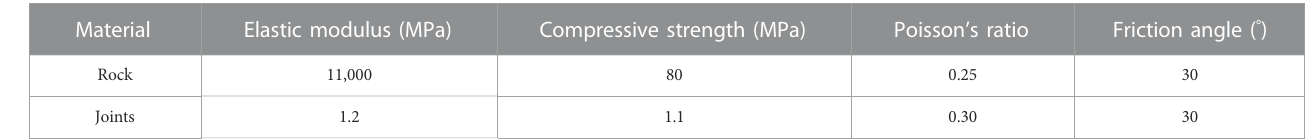
TABLE 2 Rock mechanical